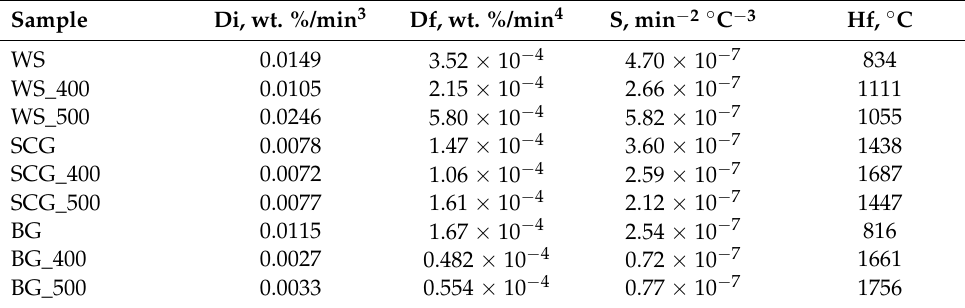
Table 2. Combustion parameters of studied feedstock and biochars.